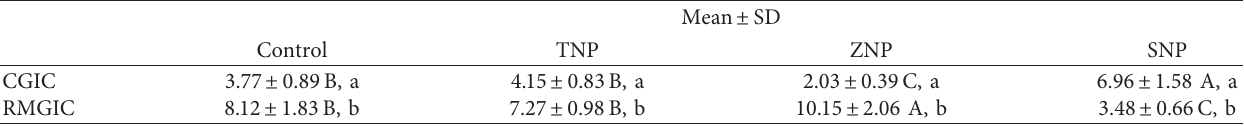
Table 2: Mean (standard deviation) of the microshear bond strength ( μ SBS, MPa) in each experimental group.